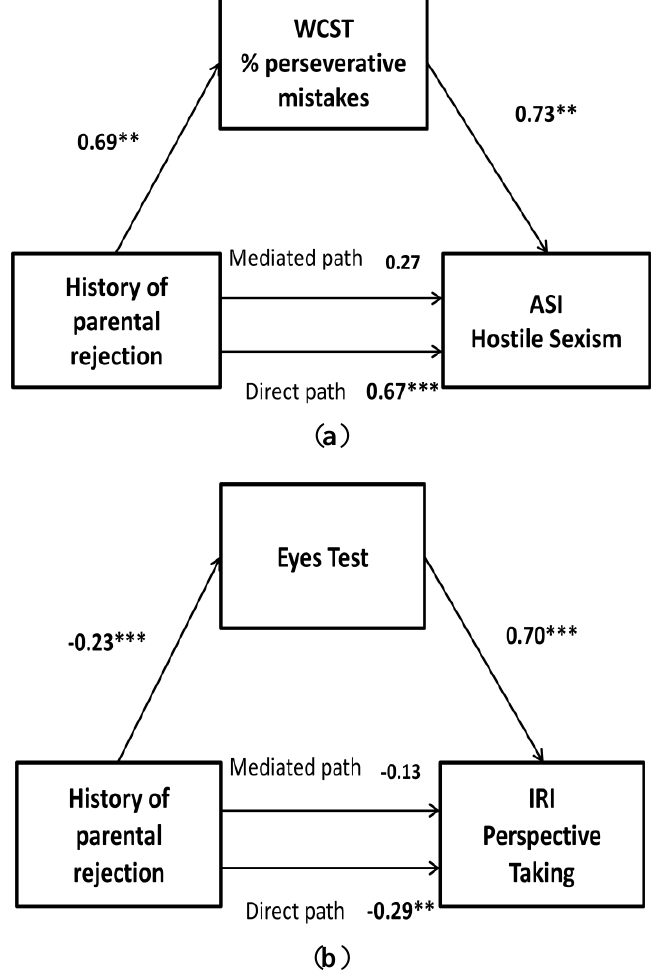
Figure 1. History of childhood parental rejection as a predictor of ( a ) ASI hostile sexism mediated by WCST% of perseverative mistakes and ( b ) IRI perspective taking mediated